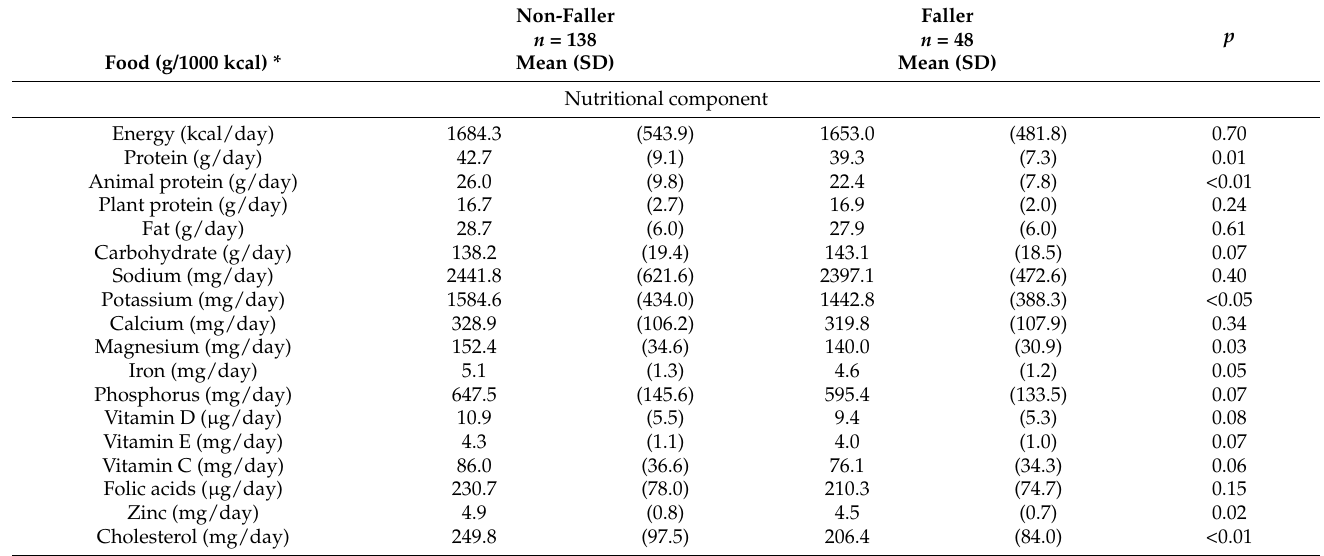
Table 3. Association of nutrient intake with falling.